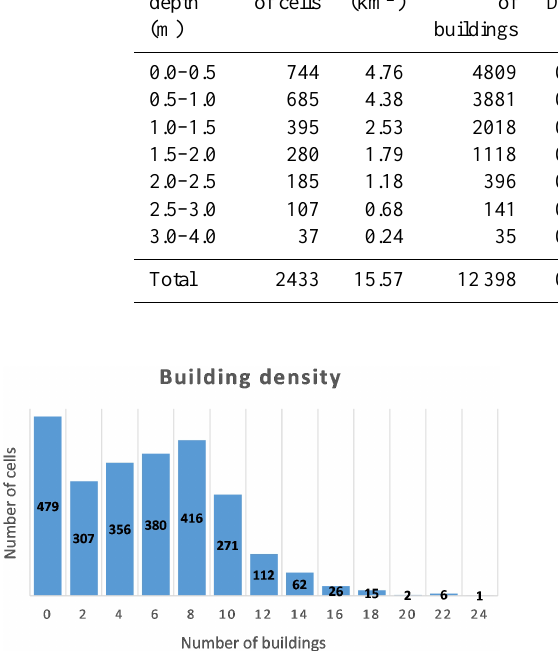
Figure 23. Distribution of buildings per cell in the inundated area selected in step 2 (see text). Each class is denoted by an even num- ber. All classes, but the first on the left, have a width of 2. This means that the column denoted by 2 contains all cells having ei- ther one or two buildings, the next denoted by 4 contains cells with three or four constructions, etc. Instead, the first column contains only cells with no buildings. Figures in the columns are the number of